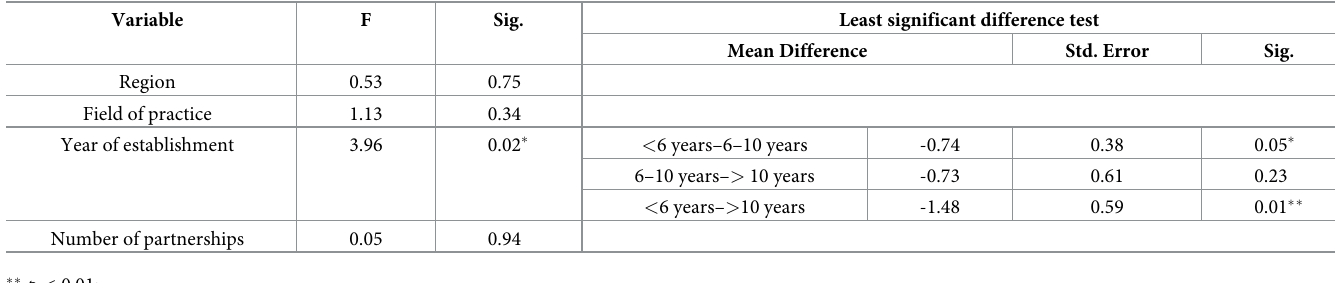
Table 7. Differences in overall implementation of the partnering life cycle practices based on nonprofit organizations’